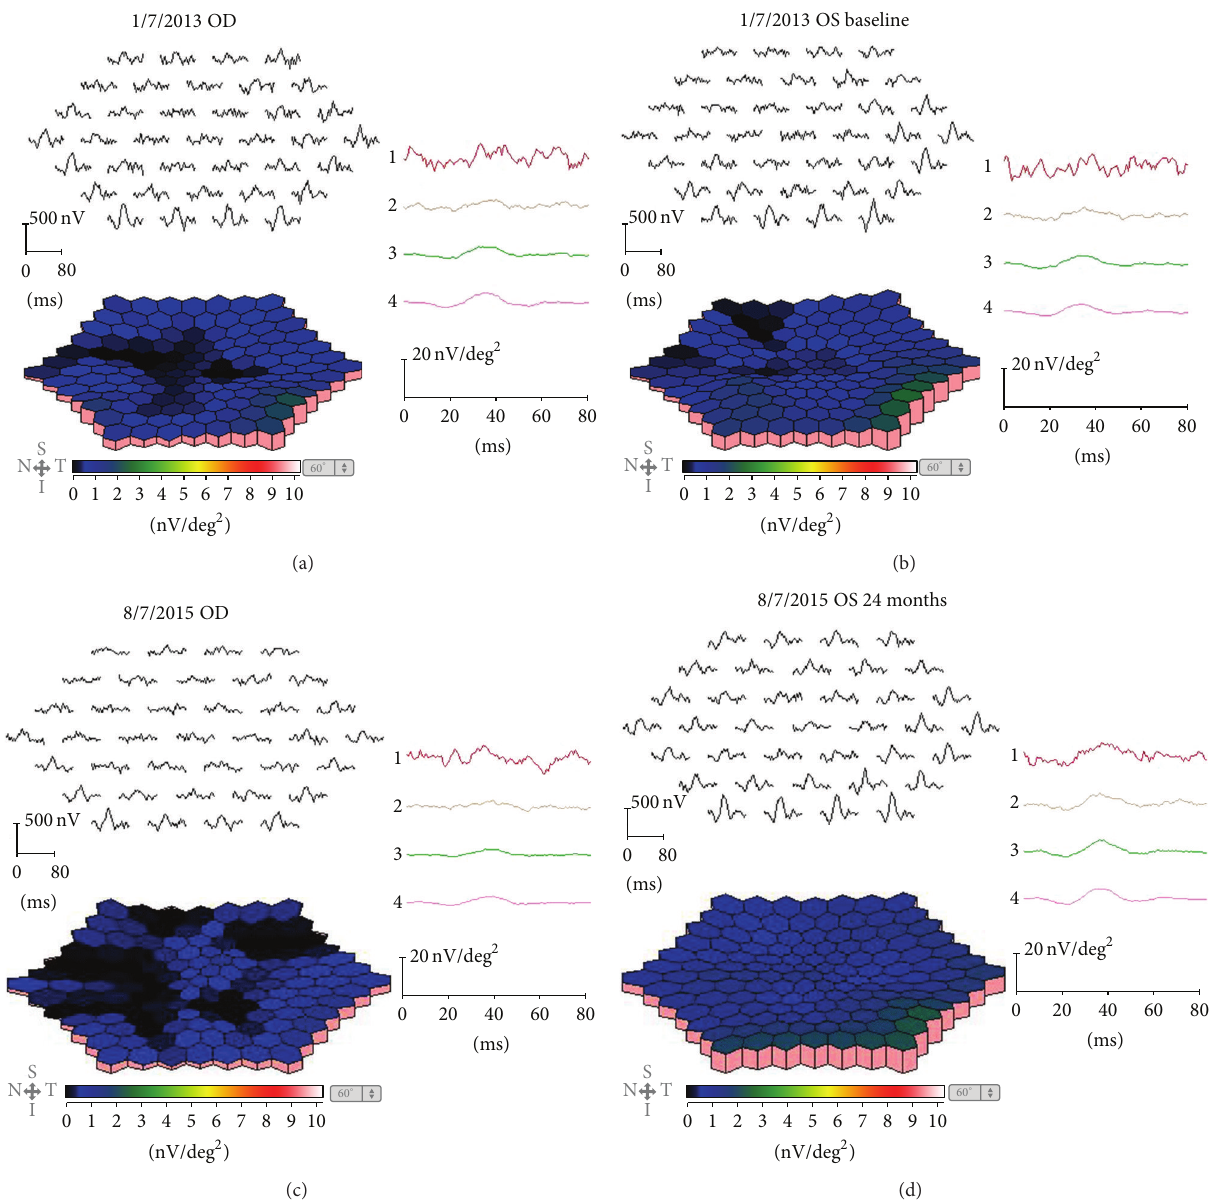
Figure 2: Local responses, topographic map, and average densities of the rings of the multifocal ERGs are shown. The baseline data from the right eye (a) and the left eye (b) of the patient and the data after 14 months of follow-up (c and d) are shown. The amplitudes of the mfERGs in the foveal area are severely reduced in both eyes at baseline. The amplitude of mfERGs after 14 months of follow-up is not